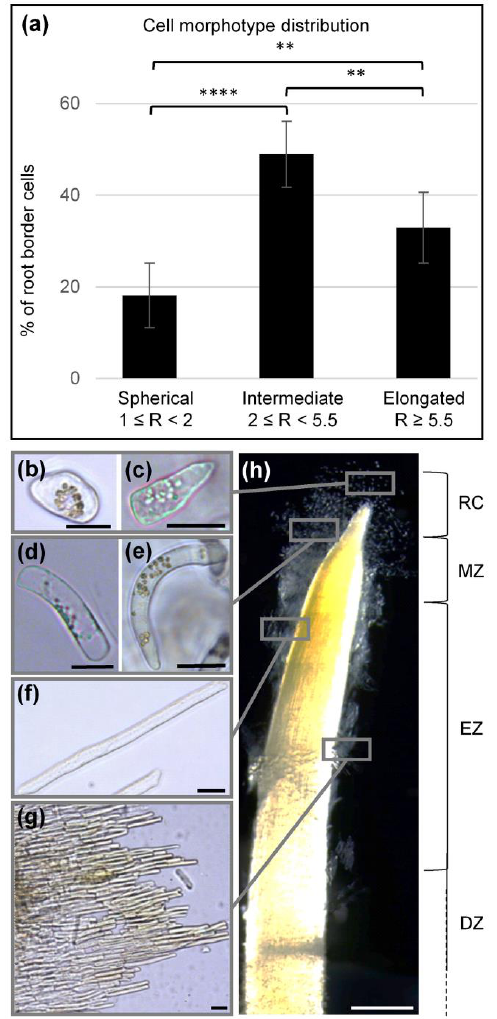
Figure 2. Root border cell morphotypes. ( a ) Histograms illustrating the proportion of different types of border cells. Three morphotypes were observed and defined as “spherical” (1 ≤ R <